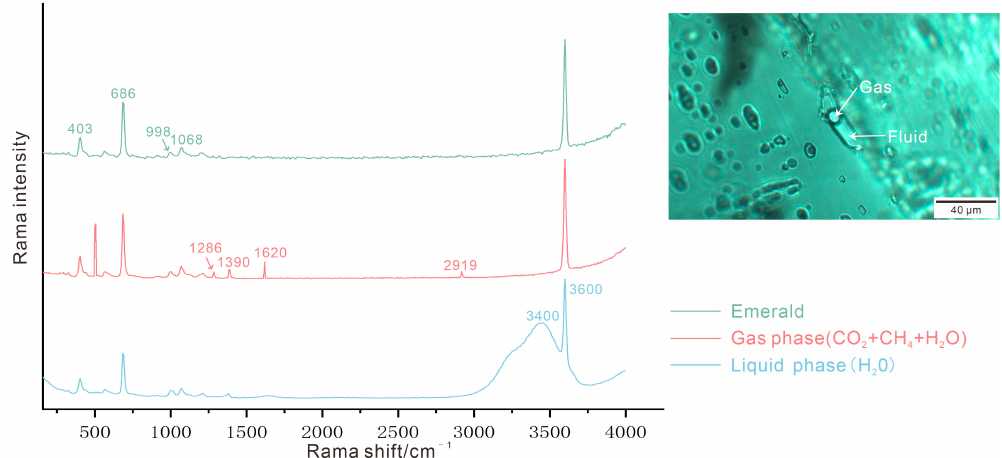
Figure 10. This rectangular two-phase inclusion in Kamakanga emerald (KAM-8) clearly displays a gas bubble. Raman spectroscopy was used to identify the host emerald (green), the CO 2 + CH 4 + H 2 O gas bubble (red), and the liquid phase (blue). The spectra are stacked for clarity.